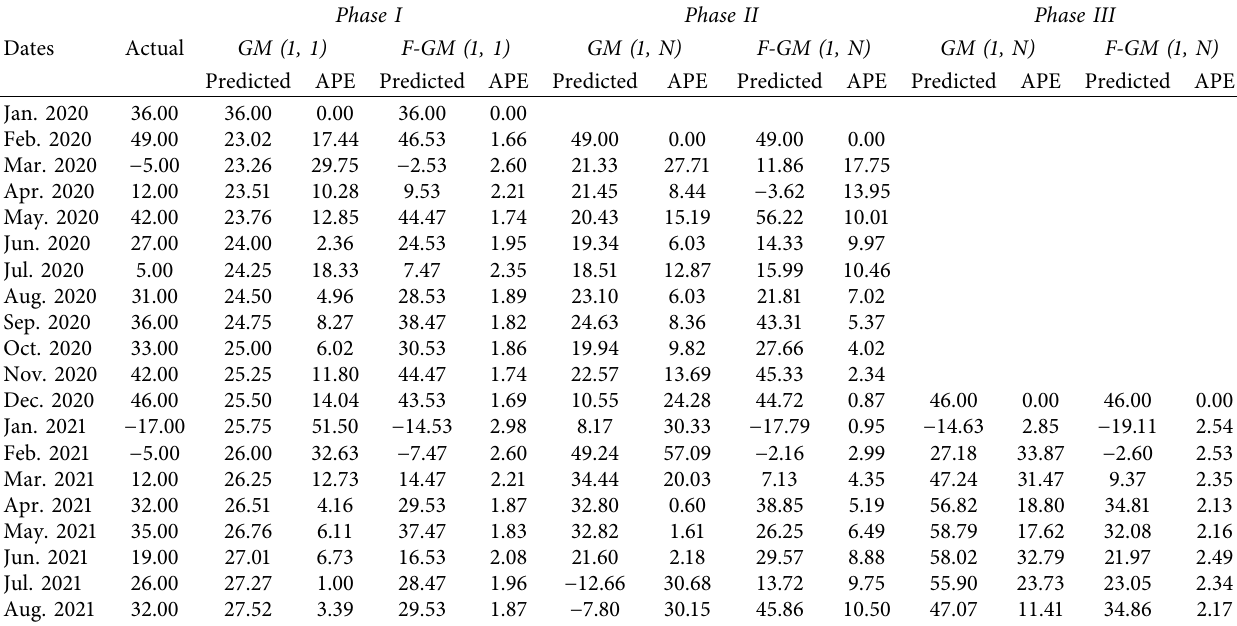
Table 9: Prediction results of travel sentiment in